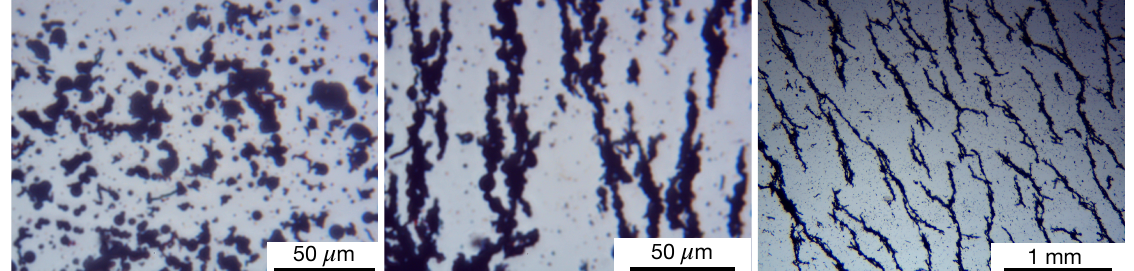
Figure 5. TEM images of µ F at increasing magnifications from left to right .